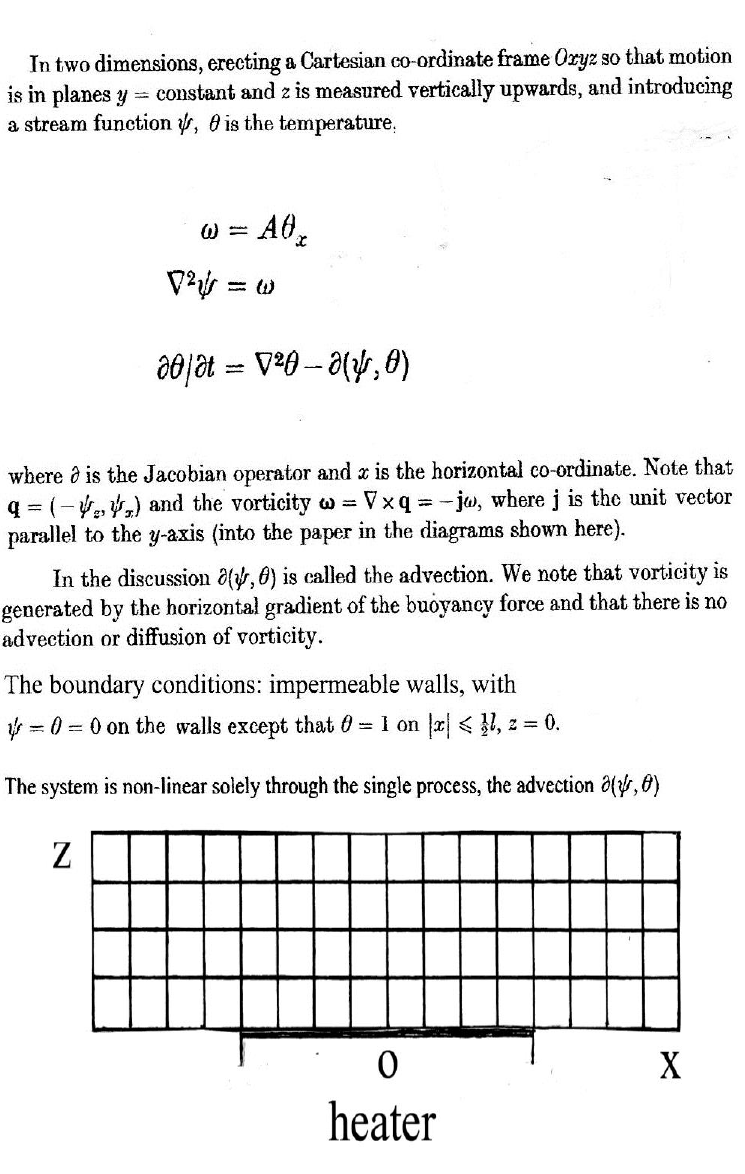
Figure 1. The equations of the 1967 model ( top ) and flow plane diagram ( bottom ). Diagram of the flow plane (bottom) showing the heated part of the base; and (for example) a 16 × 4 mesh. In a finite-difference numerical-representation the flow and temperature are determined/calculated only at the mesh joins (17 × 5 here). [Modified from Journal of Fluid Mechanics 1967, 27, 29–48 [1]; Journal of Fluid Mechanics 1967, 27, 609–623 [2]. Reproduced with permission from Elder, J.W., Steady free convection in a porous medium heated from below, Transient convection in a porous medium; published by Cambridge University Press,